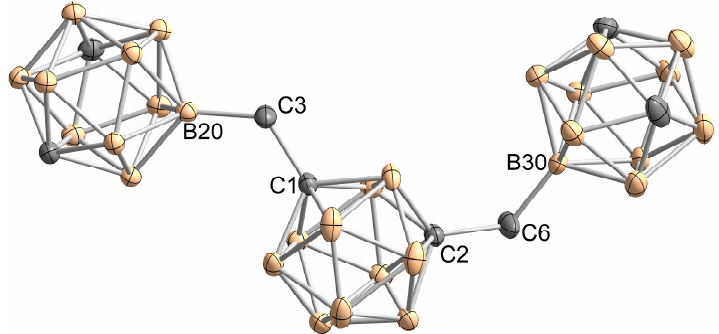
Figure 3. Molecular structure of 1,7-bis(1,7-dicarba- closo -dodecaboran-9-ylmethyl)-1,7-dicarba- closo - dodecaborane ( 4 ). Hydrogen atoms are omitted for clarity. Thermal ellipsoids are drawn at the 50% probability level. Selected bond lengths [pm] and bond angles [°]: C1 ‒ C3 153.5(2), C3 ‒ B20 160.1(3),